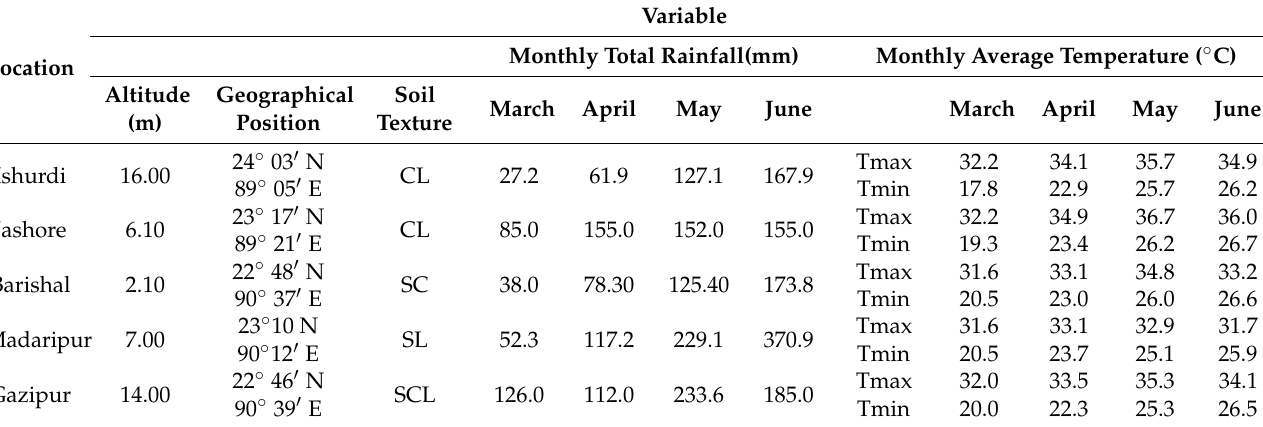
Table 2. Salient features of the study sites along with their climatic condition during 2019.